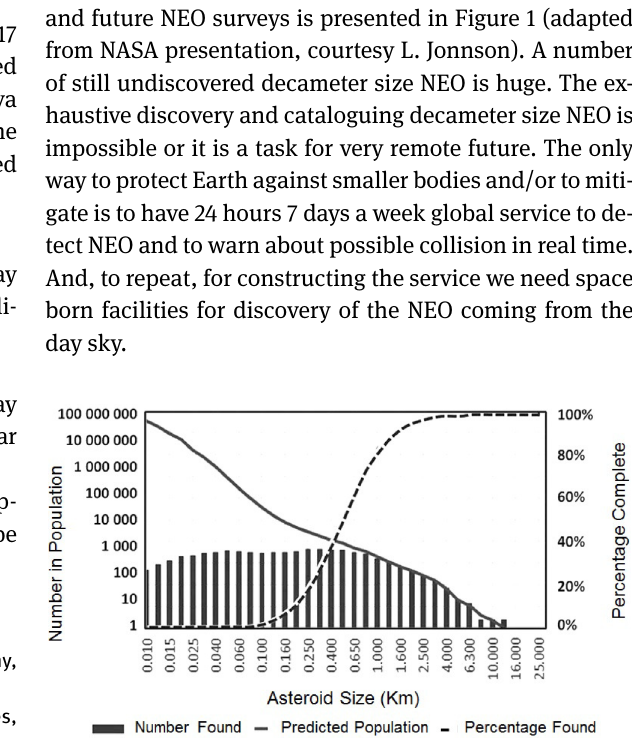
Figure 1. Completeness of existing NEO surveys